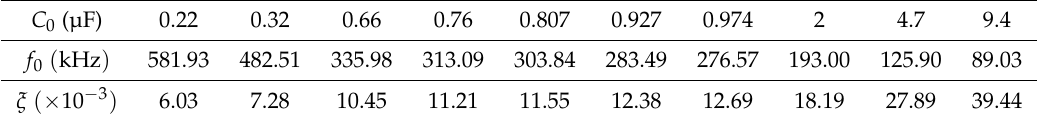
Figure 5. Schematic of the ICPT secondary circuit: ( a ) compensation capacitor and bridge rectifier; ( b ) C 0 expansion board. Table 2. Values of the capacitor C 0 used in the experiments that sets f 0 and ξ .